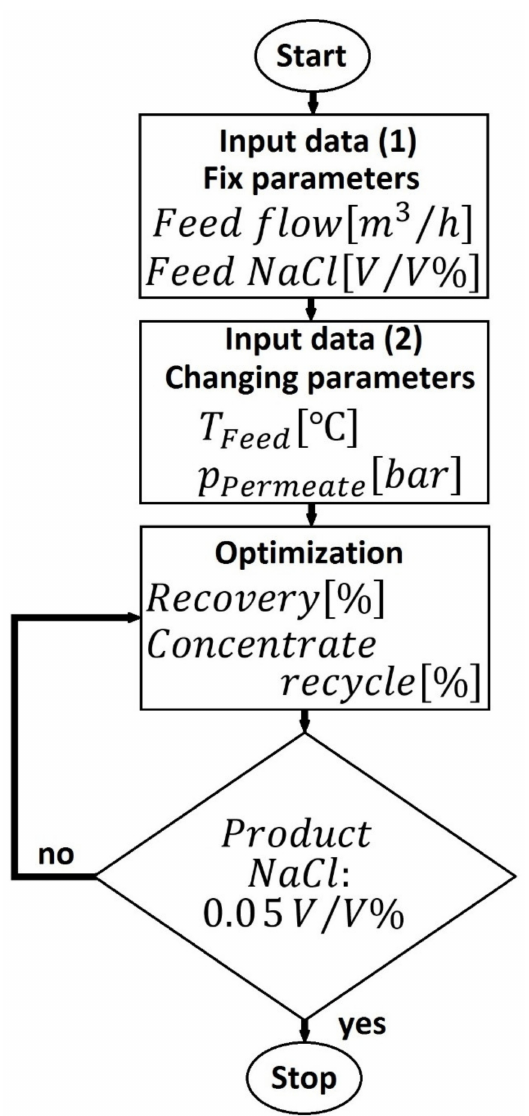
Figure 7. Flowchart of optimization process of reverse